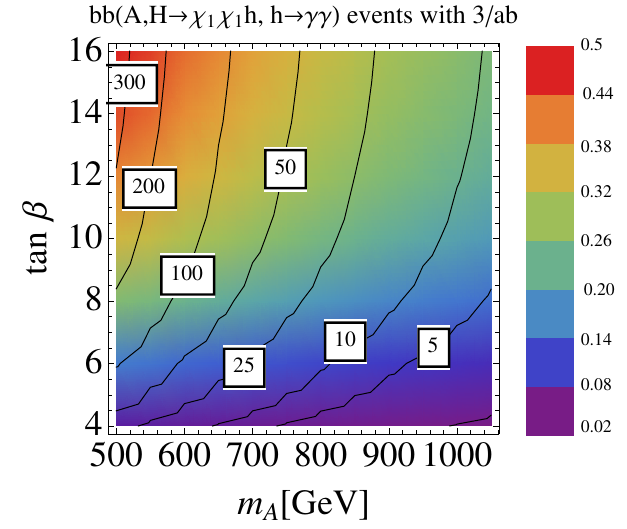
Figure 13 . The number of pp ! b (cid:22) b ( A; H ) ; ( A; H ) ! (cid:31) 1 (cid:31) h , (cid:31) h ! (cid:31) 1 h; h ! (cid:13)(cid:13) events (summed over A and H ) at the HL-LHC. For this plot, we choose the spectrum (cid:22) = m A = 2 (cid:0) 10 GeV, M 1 = (cid:22) (cid:0) 130 GeV, so that A=H ! (cid:31) 1 (cid:31) h as well as (cid:31) h ! (cid:31) 1 + h are kinematically open (for these parameters, we (cid:12)nd BR ( (cid:31) h ! (cid:31) 1 h ) (cid:25) BR ( (cid:31) h ! (cid:31) 1 Z ), where h represents a sum over 2 ; 3). The color coding shows the ratio of this production cross section (not including the BR( h ! (cid:13)(cid:13) )) to the production cross section of mono-h (cid:12)nal states from direct electroweakino production, pp ! (cid:31) i (cid:31) j ! h + =E T